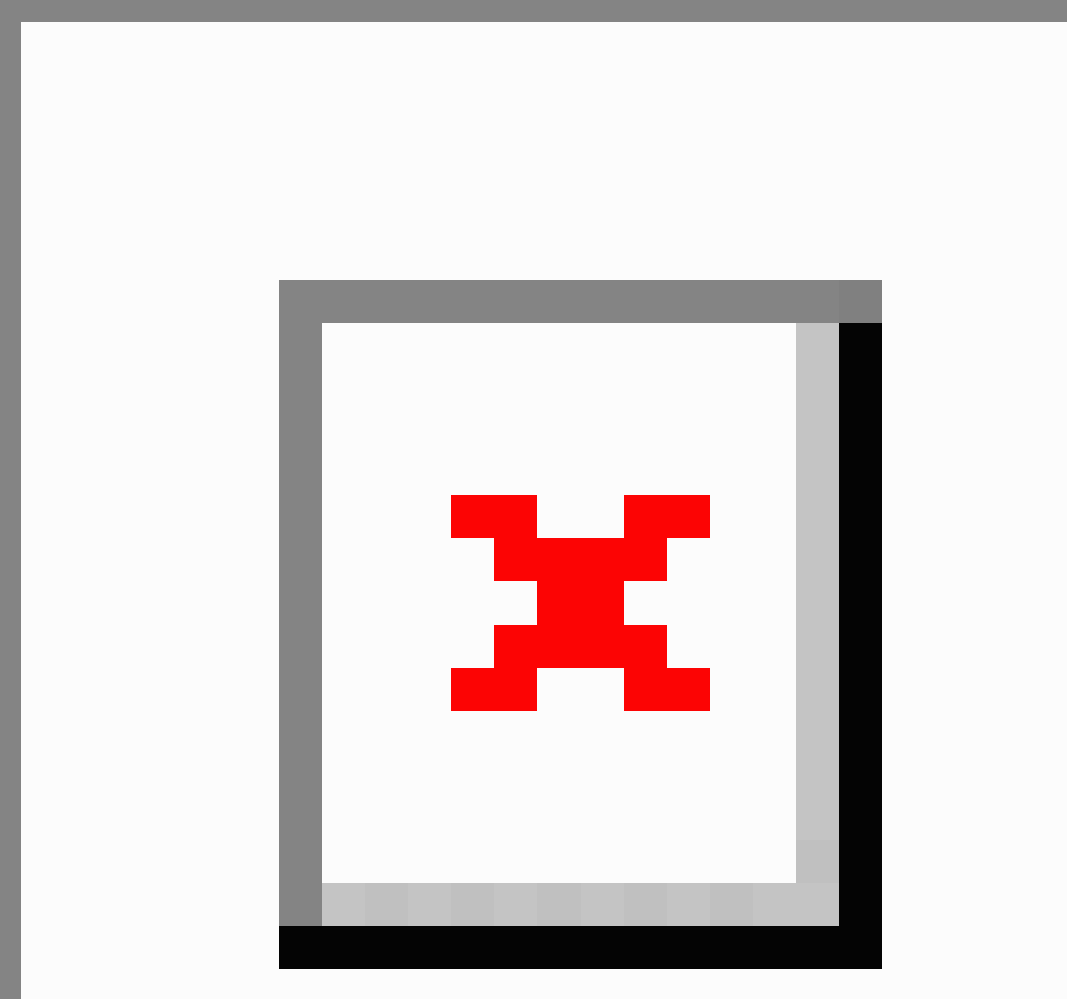
Figure 4. Weighted proportion of respondents who passed screener by educational attainment and panel vendor